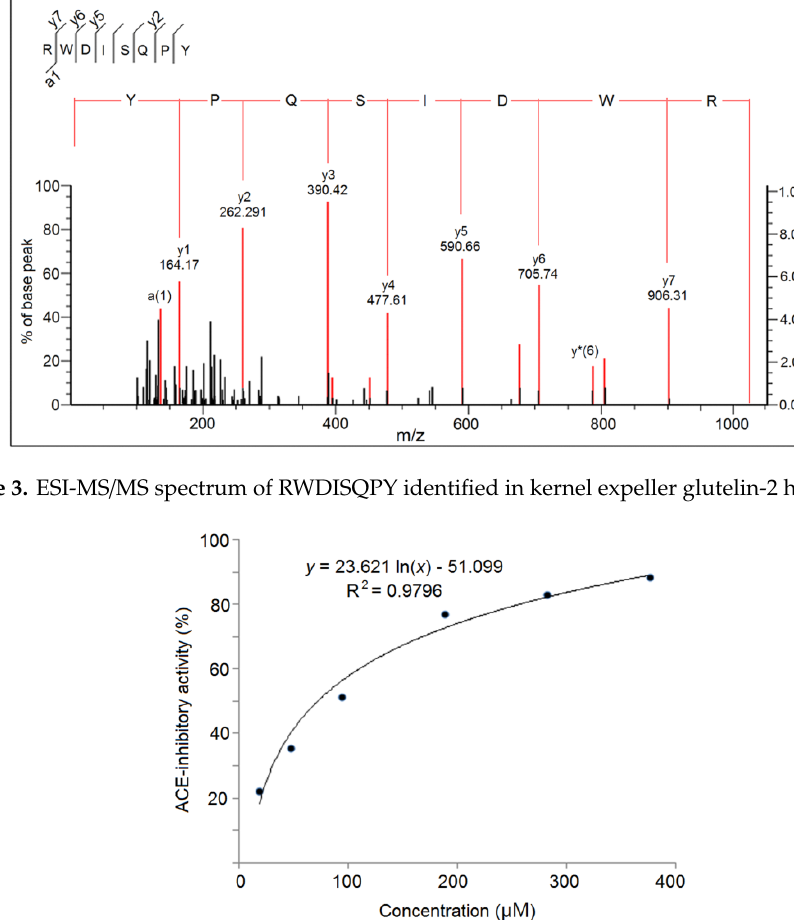
Figure 5. The Lineweaver–Burk plots of the ACE inhibition of RWDISQPY. 3.5. Molecular Docking Simulation A molecular docking study is an effective way to observe the molecular interactions between ACE-inhibitory peptides and ACE active sites, contributing to understanding the structure–activity relationship of bioactive peptides.